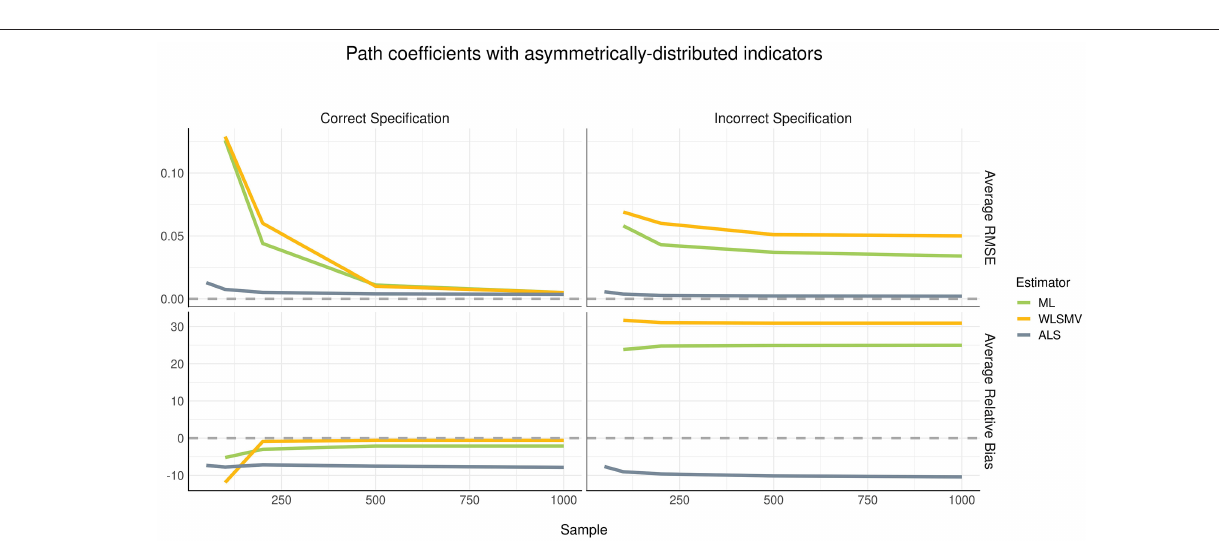
FIGURE 5 | Estimation error and bias in structural path coefficients with asymmetrically-distributed